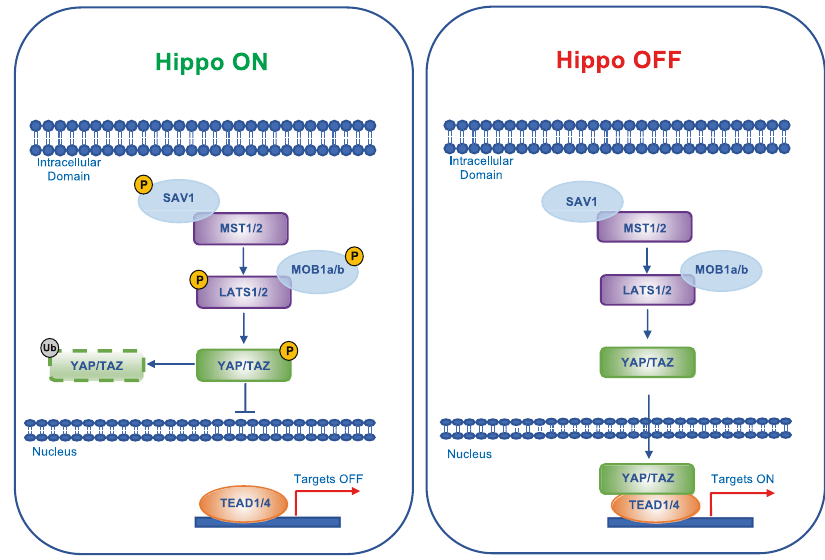
Fig. 1 Hippo signaling pathway. Schematic diagram for the Hippo pathway core components and signaling. When Hippo signaling is ON, the activated Mammalian sterile 20-like kinase 1 and 2 (MST1/2) bind Salvador homolog 1 (SAV1) and phosphorylate/activate Large tumor suppressor 1 and 2 (LATS1/2) and their cofactors MOB kinase activator 1A and 1B (MOB1A/B). The activated LATS/MOB phosphorylate YAP/TAZ which results in its cytoplasmic retention by 14-3-3 protein and proteasomal degradation. As a result, YAP/TAZ cannot interact with TEAD in an active transcriptional unit (targets OFF). When Hippo signaling is OFF, MST1/2 and LATS kinases are inactive. Unphosphorylated YAP/TAZ translocate into the nucleus and interact with TEAD (TEA Domain transcription factor) to induce the transcription of target genes (targets